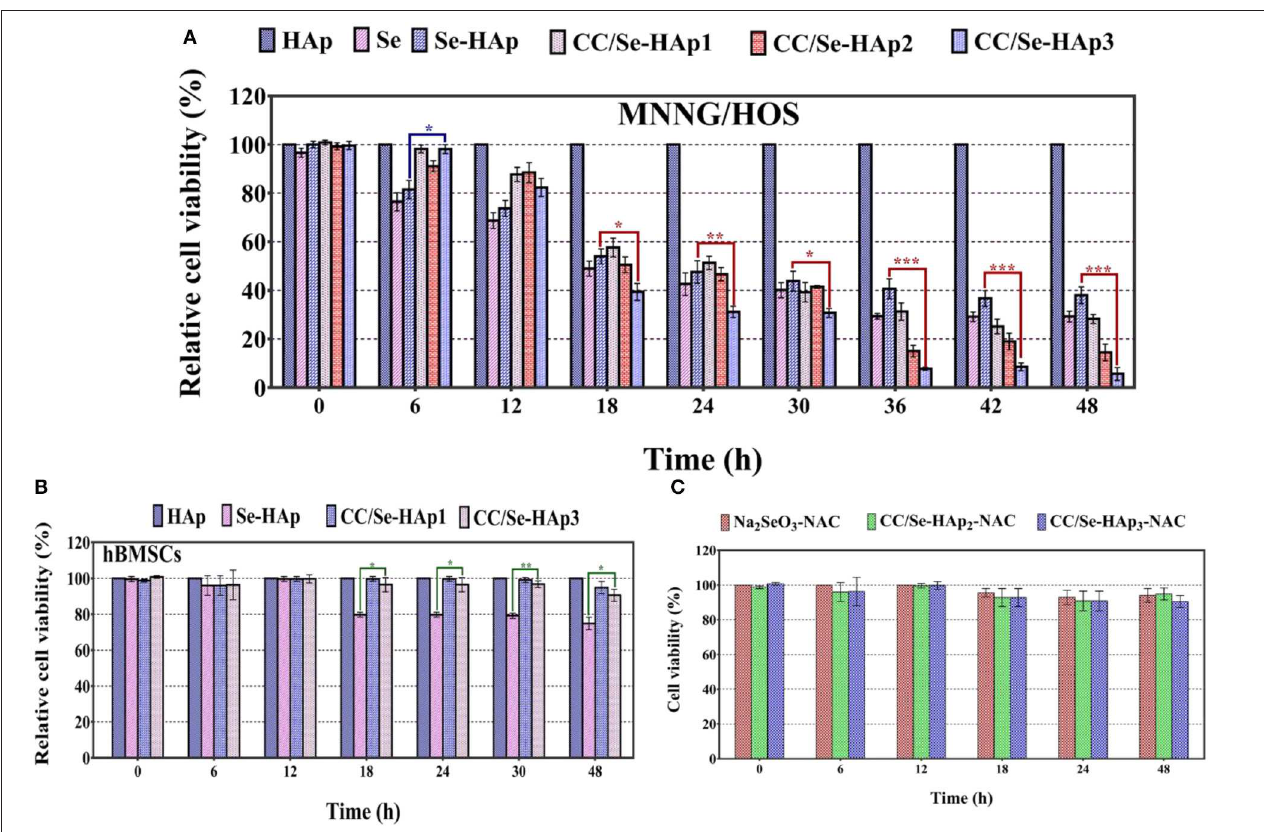
FIGURE 5 | (A) Cytotoxicity analysis of human osteosarcoma cell line (MNNG/HOS) against Se-HAp and its modification with different concentrations of catechins, i.e., 5% (CC/Se-HAp1), 7% (CC/Se-HAp2), and 10% (CC/Se-HAp3) relative to control. (B) Viability analysis of human bone marrow stem cells (hBMSCs) on Se-HAp and its modification with 5% catechins (i.e., CC/Se-HAp1) and 10% catechins (i.e., CC/Se-HAp3) relative to control. (C) ROS inhibitor attenuated the cytotoxic effect of nanoparticles, which resulted in higher cell viability. * p < 0.01, ** p < 0.001, *** p < 0.0001 indicate significant differences of CC/Se-HAp-3 in comparison with